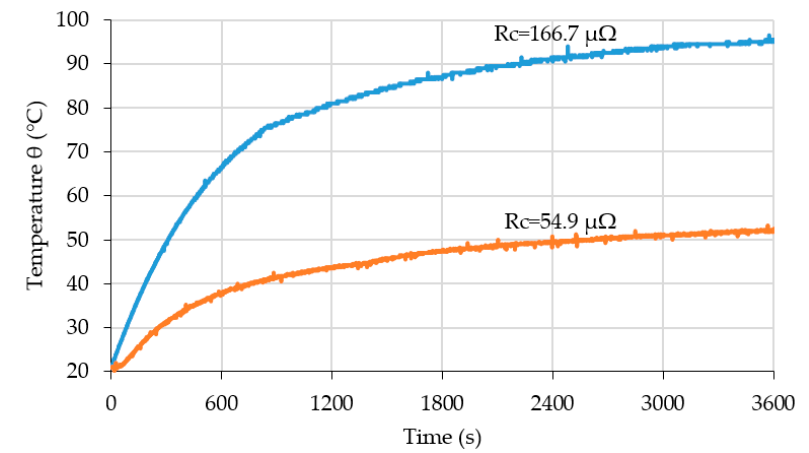
Figure 11. Temperature variation from the contact area by different contact resistances.